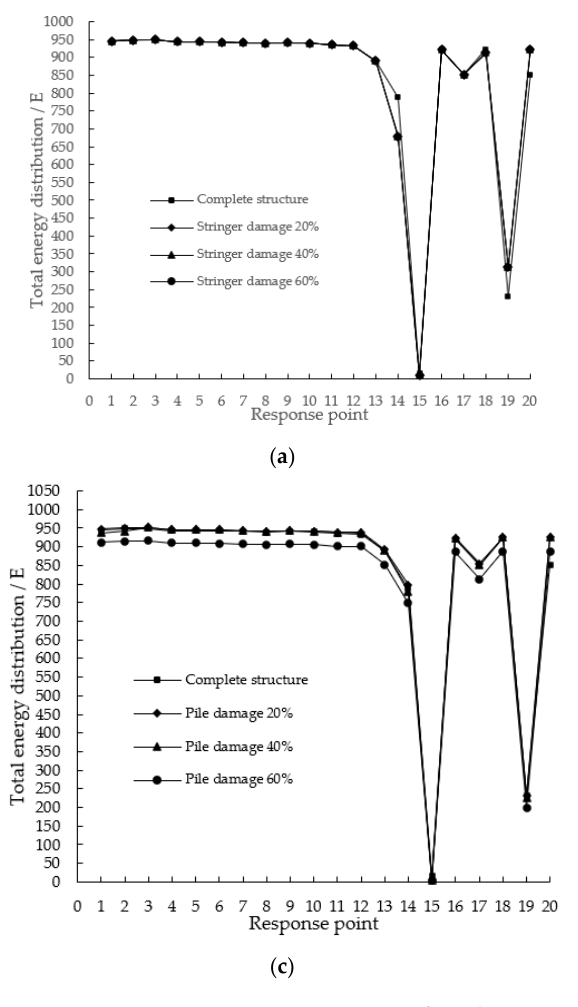
Figure 6. Curves of acceleration response of response points from No. 1 to No. 20 of damaged wharf frame structure. ( a ) Comparison of dynamic response energy distribution between longitudinal beam damage and complete structure. ( b ) Comparison of dynamic response energy distribution between crossbeam damage and complete structure. ( c ) Comparison of dynamic response energy distribution between pile damage and complete structure.